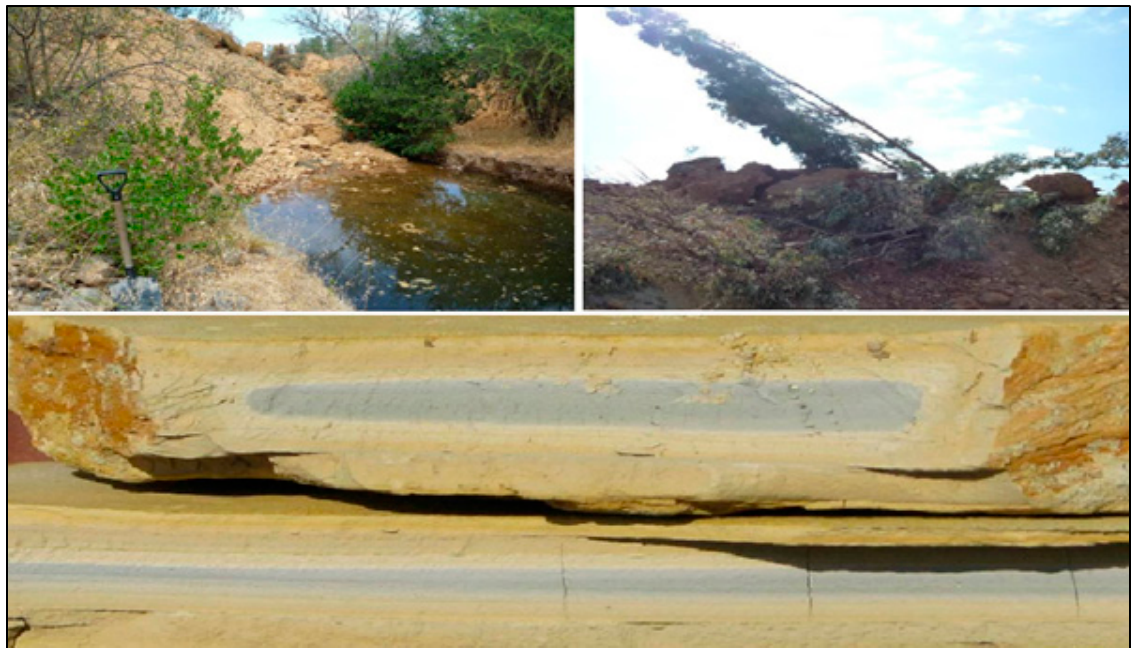
Figure 20. Tailings spill in Las Palmas creek and collapsed tailings stratigraphy